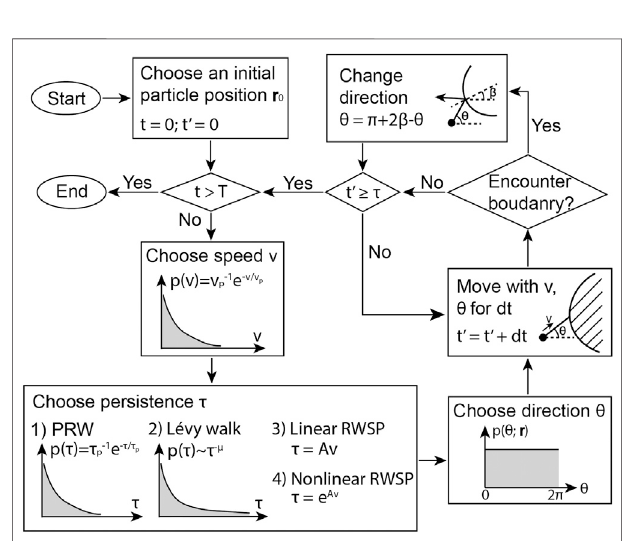
FIGURE 2 | The pipeline of the Monte Carlo simulation of a particle performing PRW, Lévy walk, linear RWSP and nonlinear RWSP. T is the total simulation time. t is the current simulation time. t ’ is the time the particle has moved along a straight line. dt is the time step of the simulation (i.e. dt (cid:2) 0 . 001 s in this